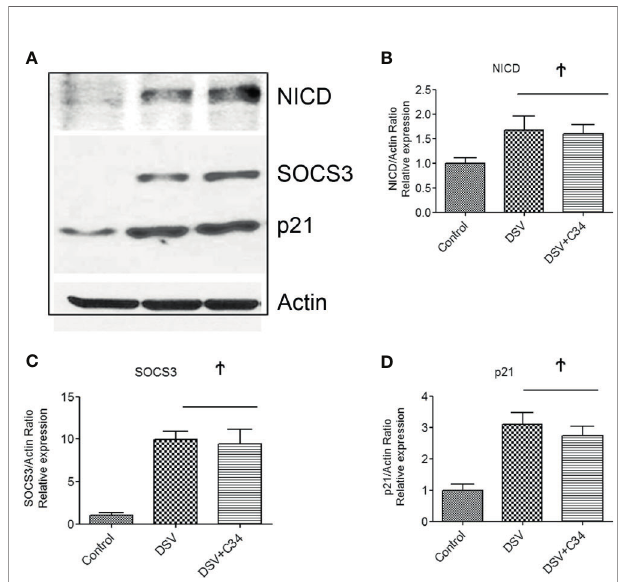
FIGURE 5 | DSV-Induced Notch Activation occurs independent of TLR4 activation (A) RAW cells (8x10 5 ) were fi rst treated with 15µm C34, A TLR4 inhibitor for 30 mins prior to infection with DSV. Cells were harvested and protein lysate was prepared. Fifty m g of protein lysate was separated on SDS- PAGE and analyzed for NICD, SOCS3, and p21 expression by Western blotting. Actin was used as a loading control. (B – D) Quanti fi cation of Western blots. Blots were quanti fi ed with ImageJ by analyzing the ratio of protein of interest/Actin. Data represents Mean ± SEM from at least three independent experiments. Values were normalized to control. Ϯ p >